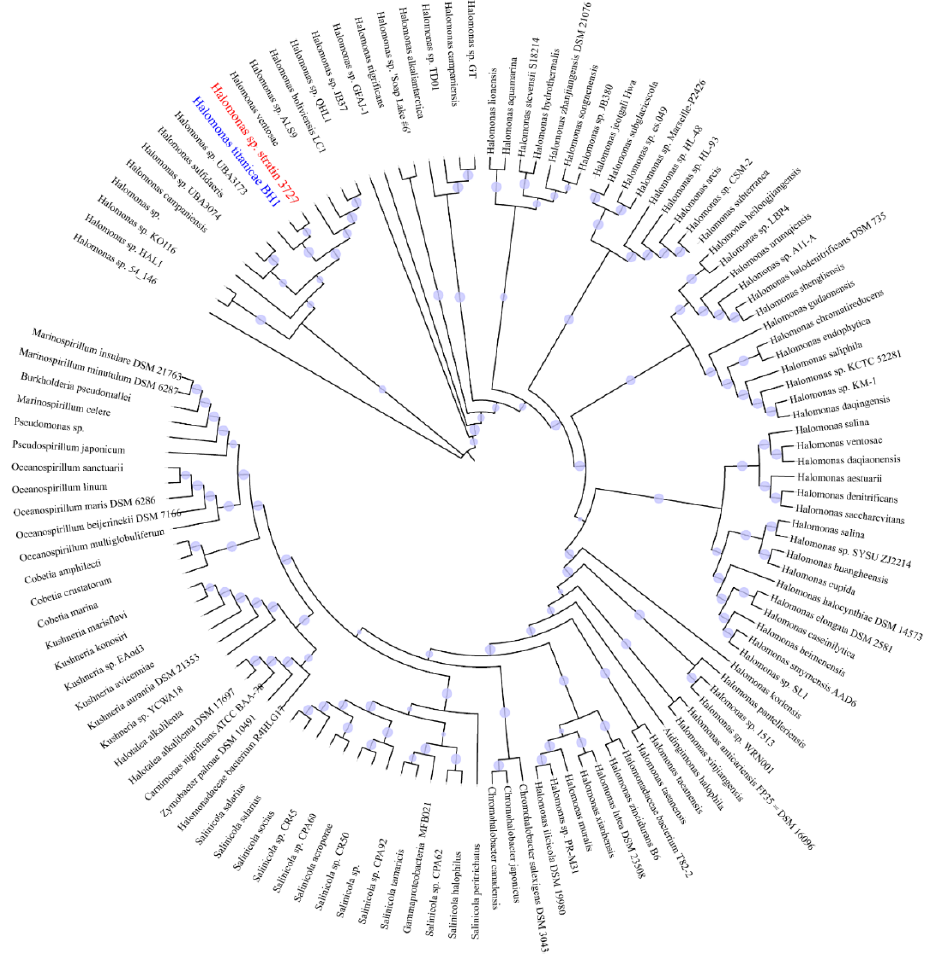
Figure 2. Phylogenetic placement of Halomonas sp. strain 3727. The maximum-likelihood phylogenetic tree was constructed using the concatenated alignment of 16 ribosomal proteins. Bootstrap values were based on 100 replicates, and percentages ≥50% are shown with light blue circles.